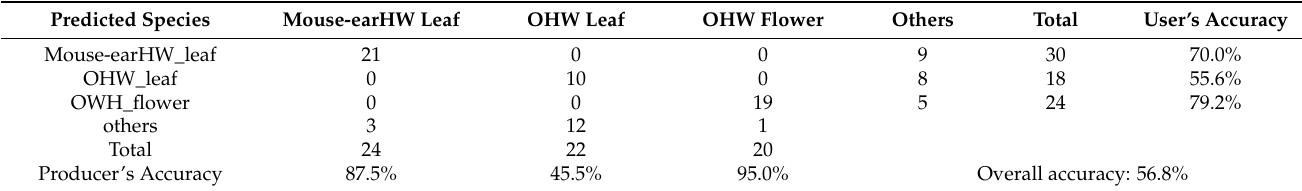
Table 7. Highlight of the accuracy of classification of the targeted weeds using the emulated multispectral profiles for the Parrot Sequoia multispectral